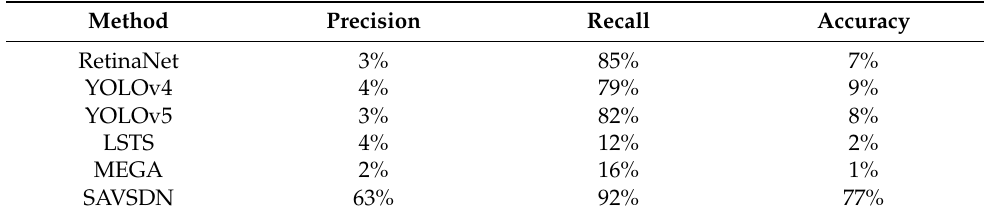
Table 3. System comparison and the corresponding performances for spark